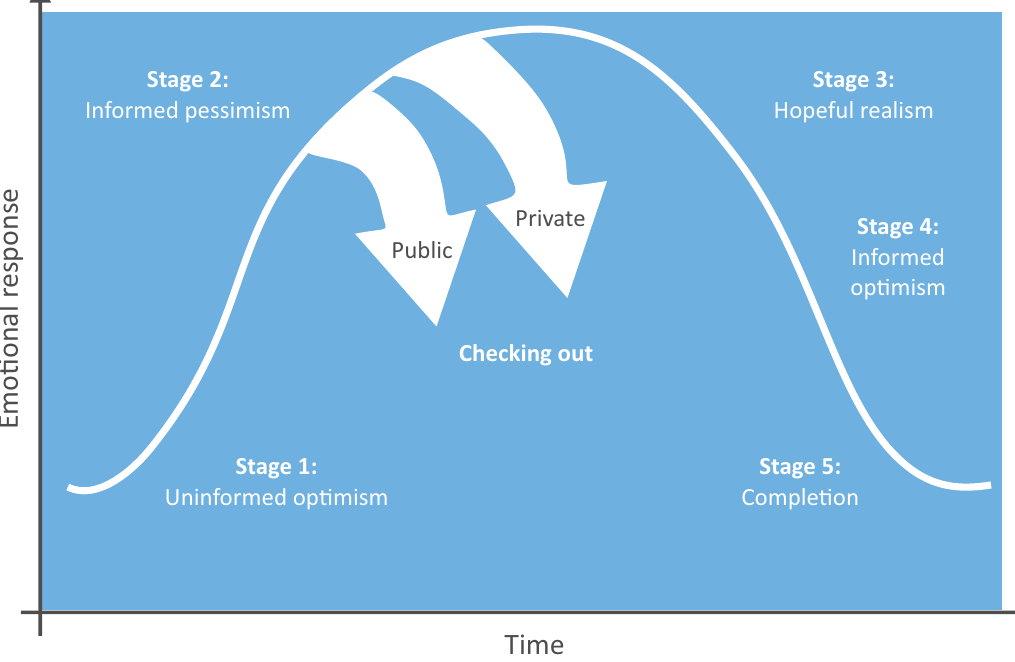
Figure 1. The 5 phases of resistance to